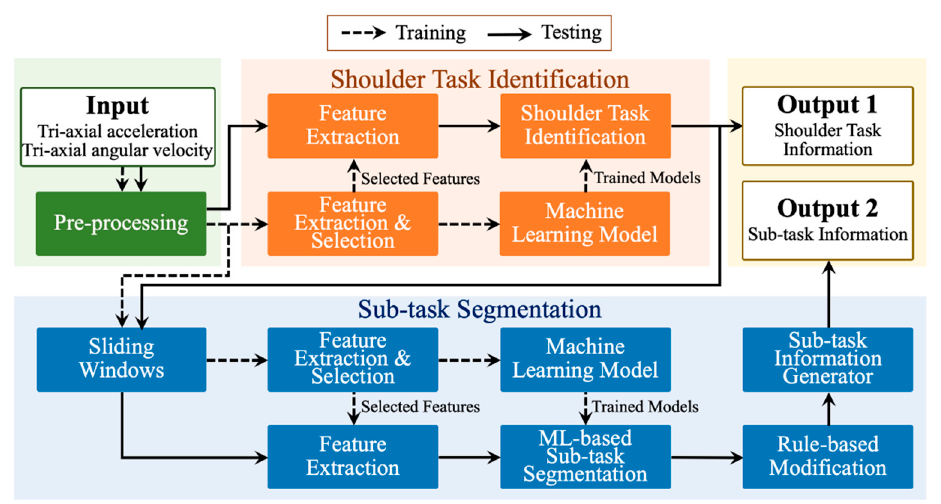
Figure 1. The framework of the automatic shoulder task identification and sub-task segmentation.